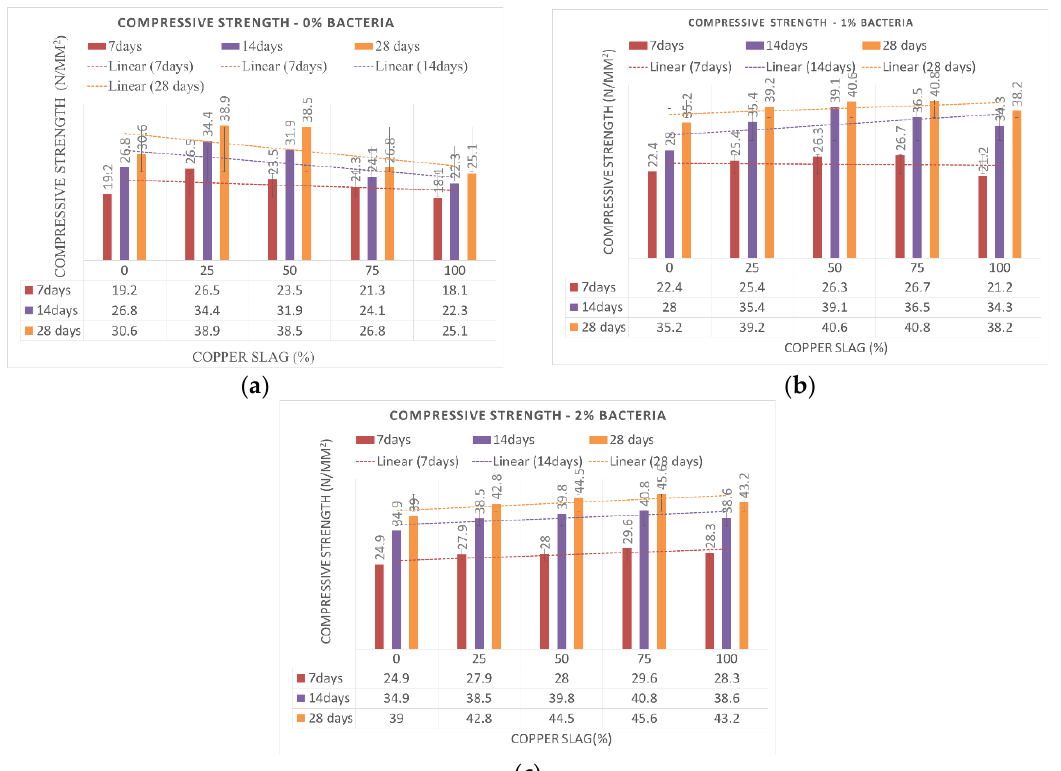
Figure 11. Compressive strength of copper slag concrete with micro-organisms. ( a ) 0% bacteria. ( b ) 1% bacteria. ( c ) 2%